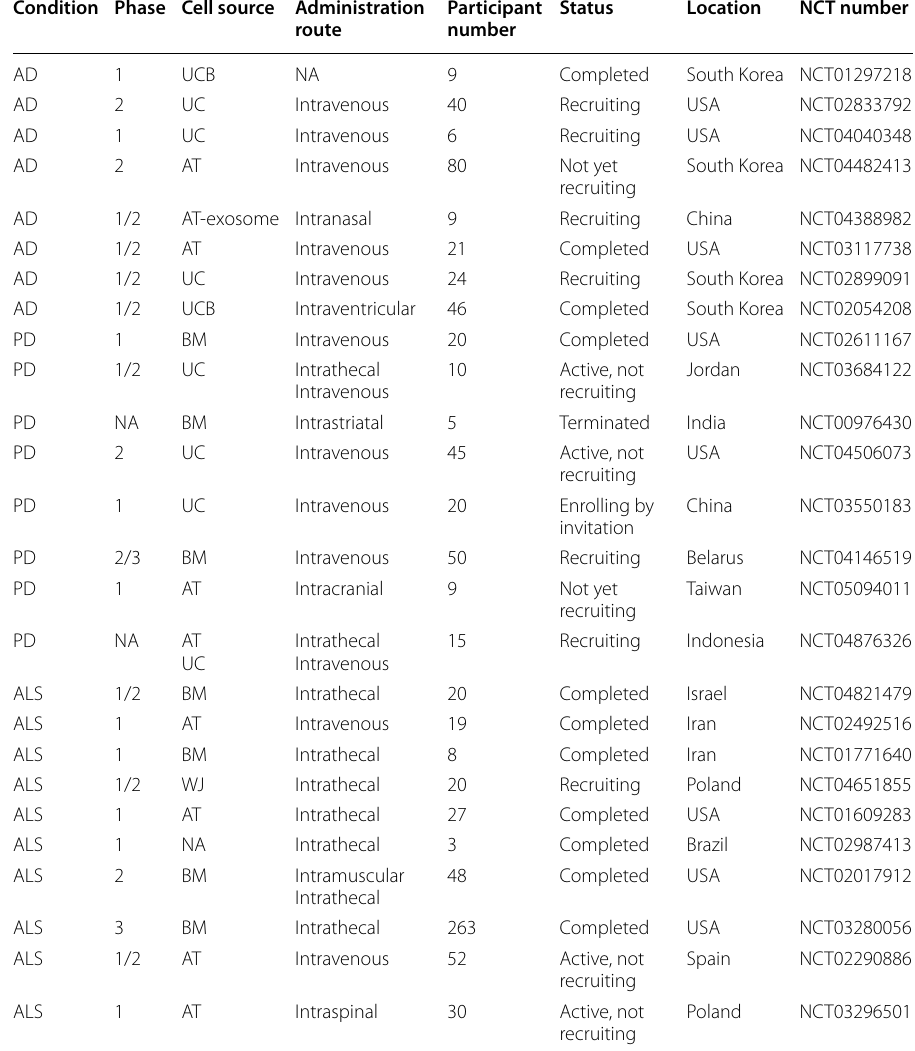
Table 4 Summary of important clinical trials based on MSC therapy in common neurodegenerative diseases (April